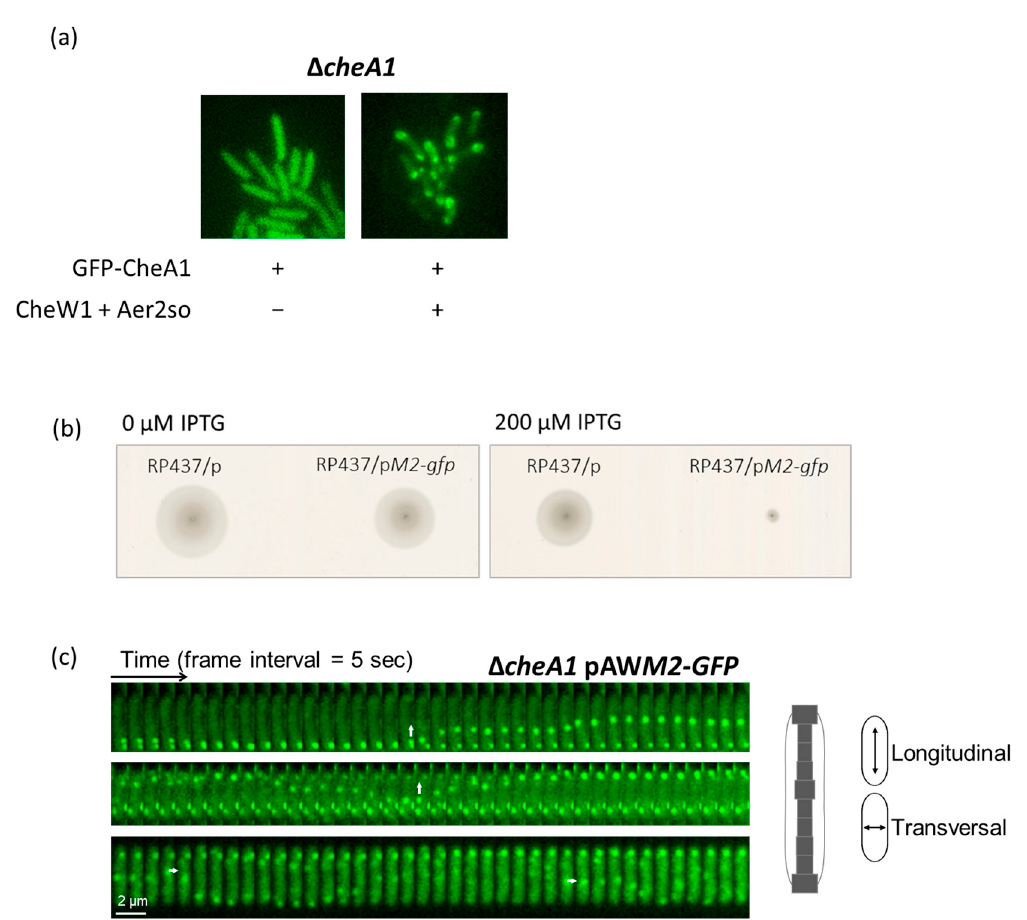
Figure 4. Subcellular localization of Che1 proteins in S. oneidensis and time-lapse recording. ( a ) Fluorescence images of the Δ cheA1 strain containing either p cheA1-GFP or pGFP- AWM2, allowing the production of GFP-CheA1 alone or in complex with Aer2so and CheW1, respectively. Cells are from the stationary phase of growth in the minimum medium. Images are representative of at least three independent experiments. ( b ) Aer2so-GFP inhibits E. coli chemotaxis. E. coli RP437 producing, or not producing, Aer2so-GFP were inoculated in tryptone soft agar with 0 or 200 μ M IPTG. The plates shown are representative of at least three independent experiments. ( c ) Fluorescence images of three representative cells showing the localization of Aer2so-GFP in a complex with CheA1 and CheW1, in the Δ cheA1 strain. Cells are from the stationary phase of growth in a minimum medium. In total, 40 images were acquired with a frame interval of 5 s. The histograms of the fluorescent cluster distribution across the transversal axis cells are shown to the right of the fluorescence images. On the x -axis, the frequency of the clusters is represented and, on the y -axis, their relative position in the cell. White arrows show the longitudinal and transversal movements of the Aer2so-GFP clusters. The analysis was performed from three independent experiments.